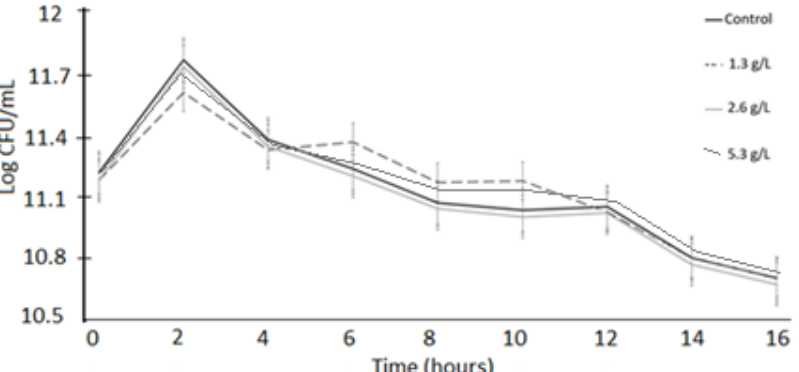
Figure 1. Log counts of S. thermophilus as influenced by carao concentration over the incubation period of 16 h.